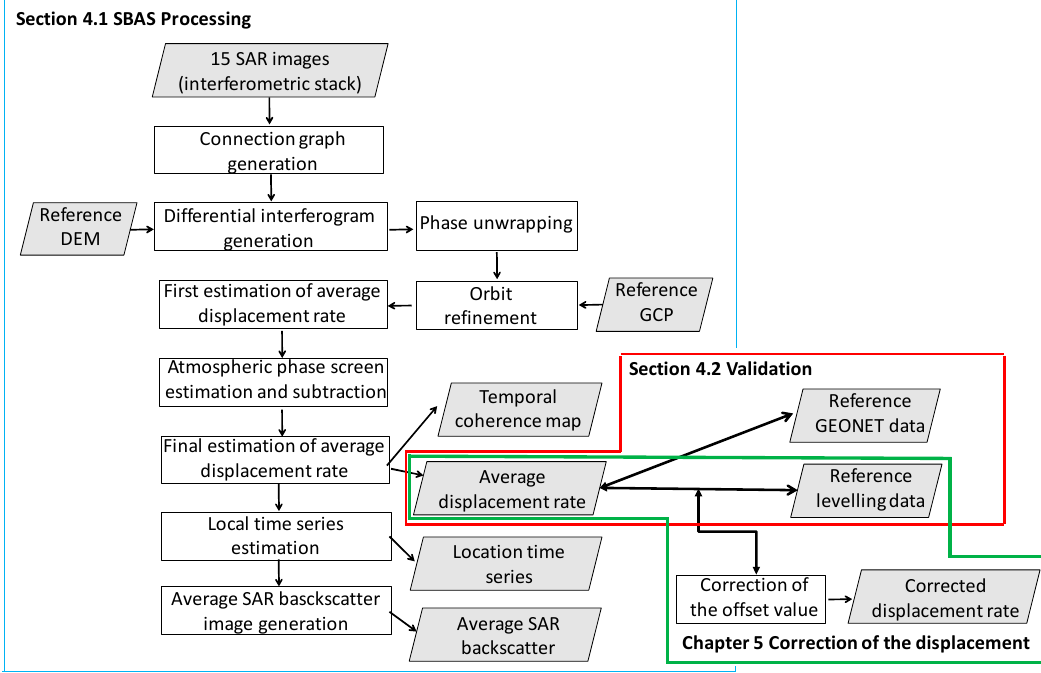
Figure 3. Flowchart of the short baseline subset method used in this study. DEM, digital elevation model; GCP, ground control point.